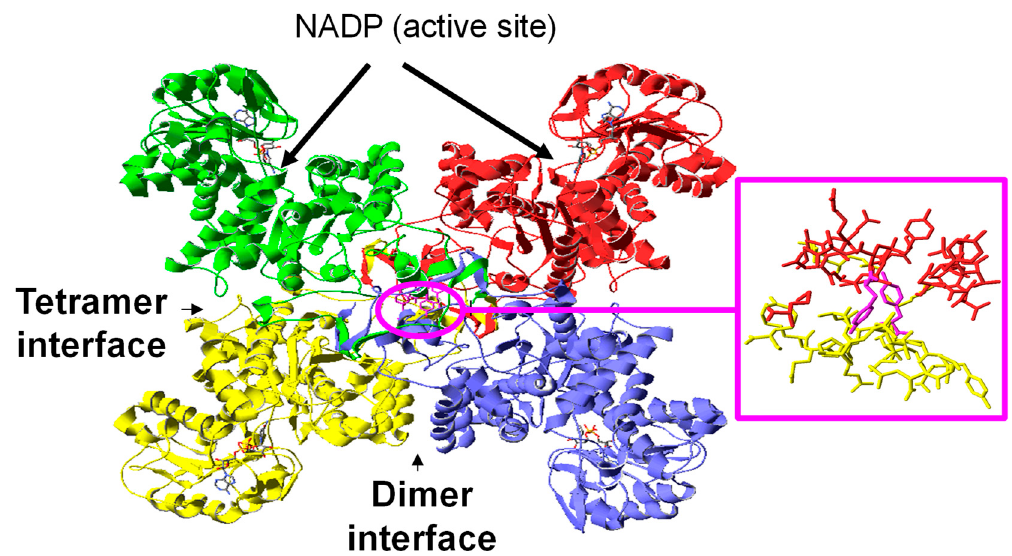
Figure 6. Schematic drawing of the model of the quaternary structure of the malic enzyme from A. thaliana showing Y73 (magenta) and details of the residues within 10 Å from Y73, which reveal its interfacial location. The four monomers are depicted in different colors.